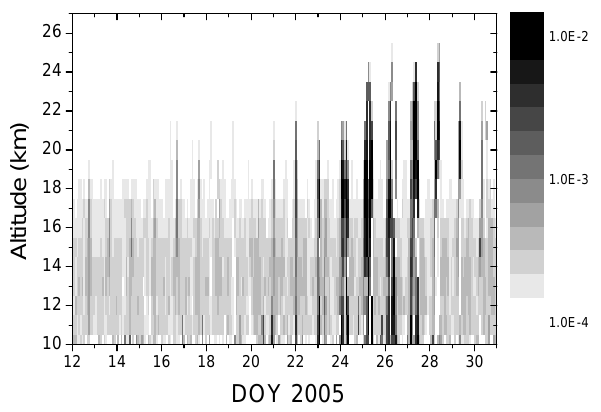
Fig. 2. Vertical profiles of aerosol extinction coefficient (in km − 1 ) at the 756nm wavelength measured by SAGE III in the Northern Polar region (zonal mean, 66–72 ◦ N) during 13–30 January 2005. Logarithmic grey scale is shown on the right